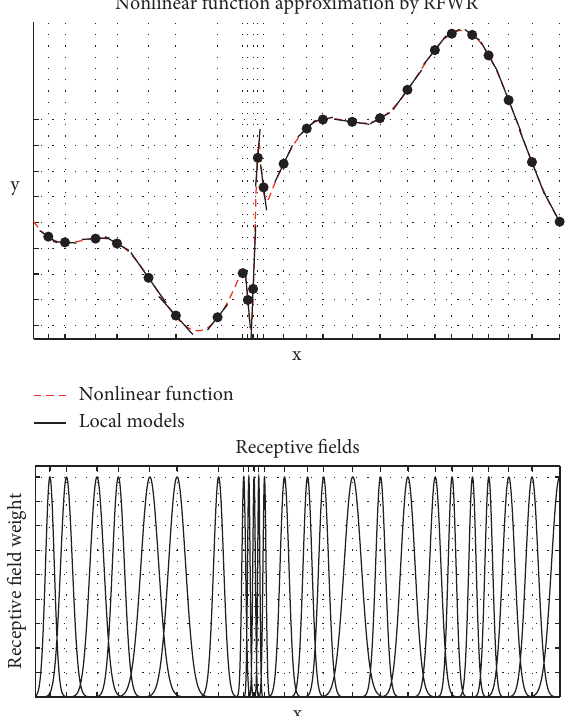
Figure 2: Example of RFWR approximation of a complex non- linear function and the distribution of receptive